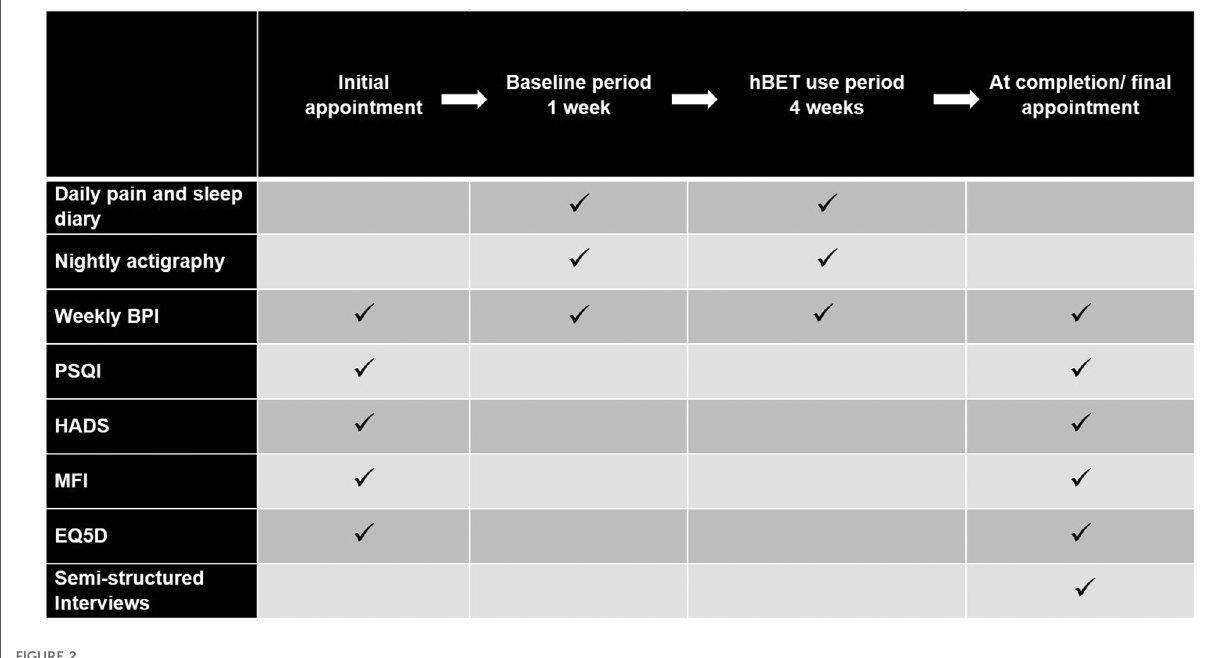
FIGURE 2 Study fl ow and assessment schedule.